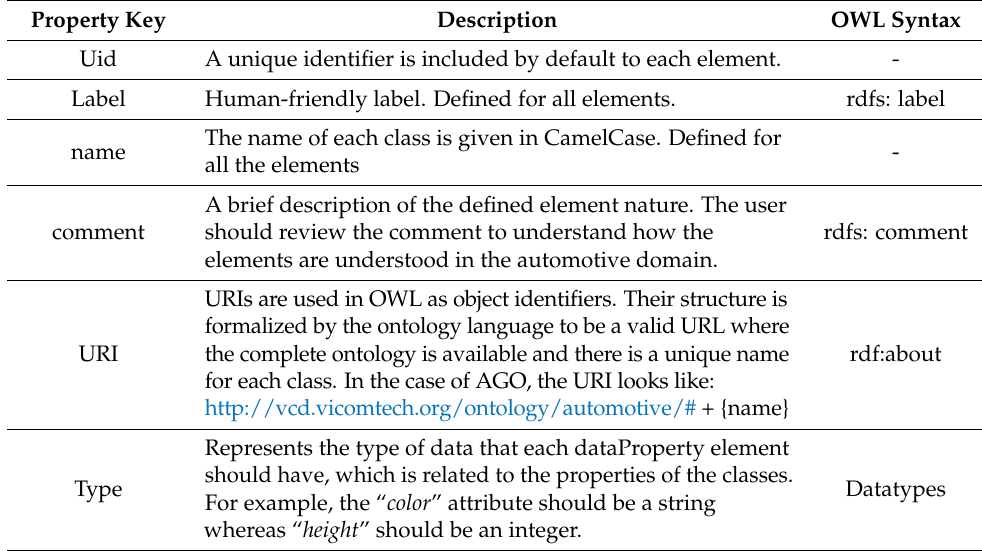
Table 3. Property key summary and OWL syntax